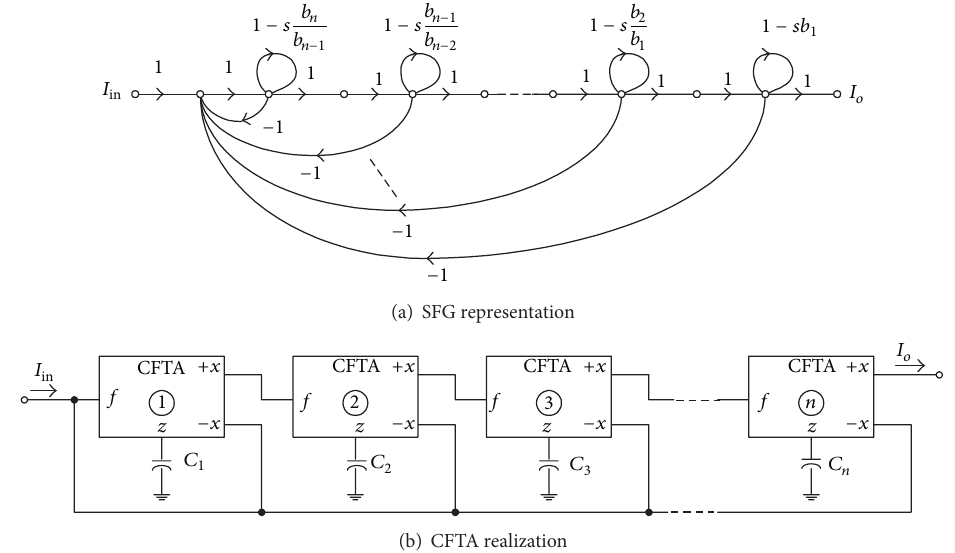
Figure 7: Realization of n th-order all-pole lowpass current transfer